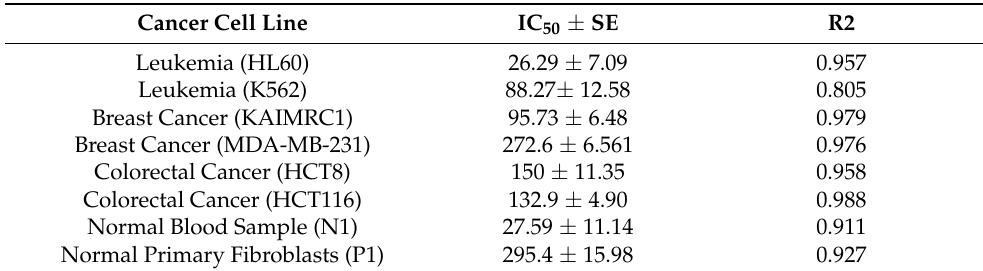
Table 2. The IC 50 values of myrrh using breast, colorectal, and leukemia cell lines and primary fibroblasts and normal blood